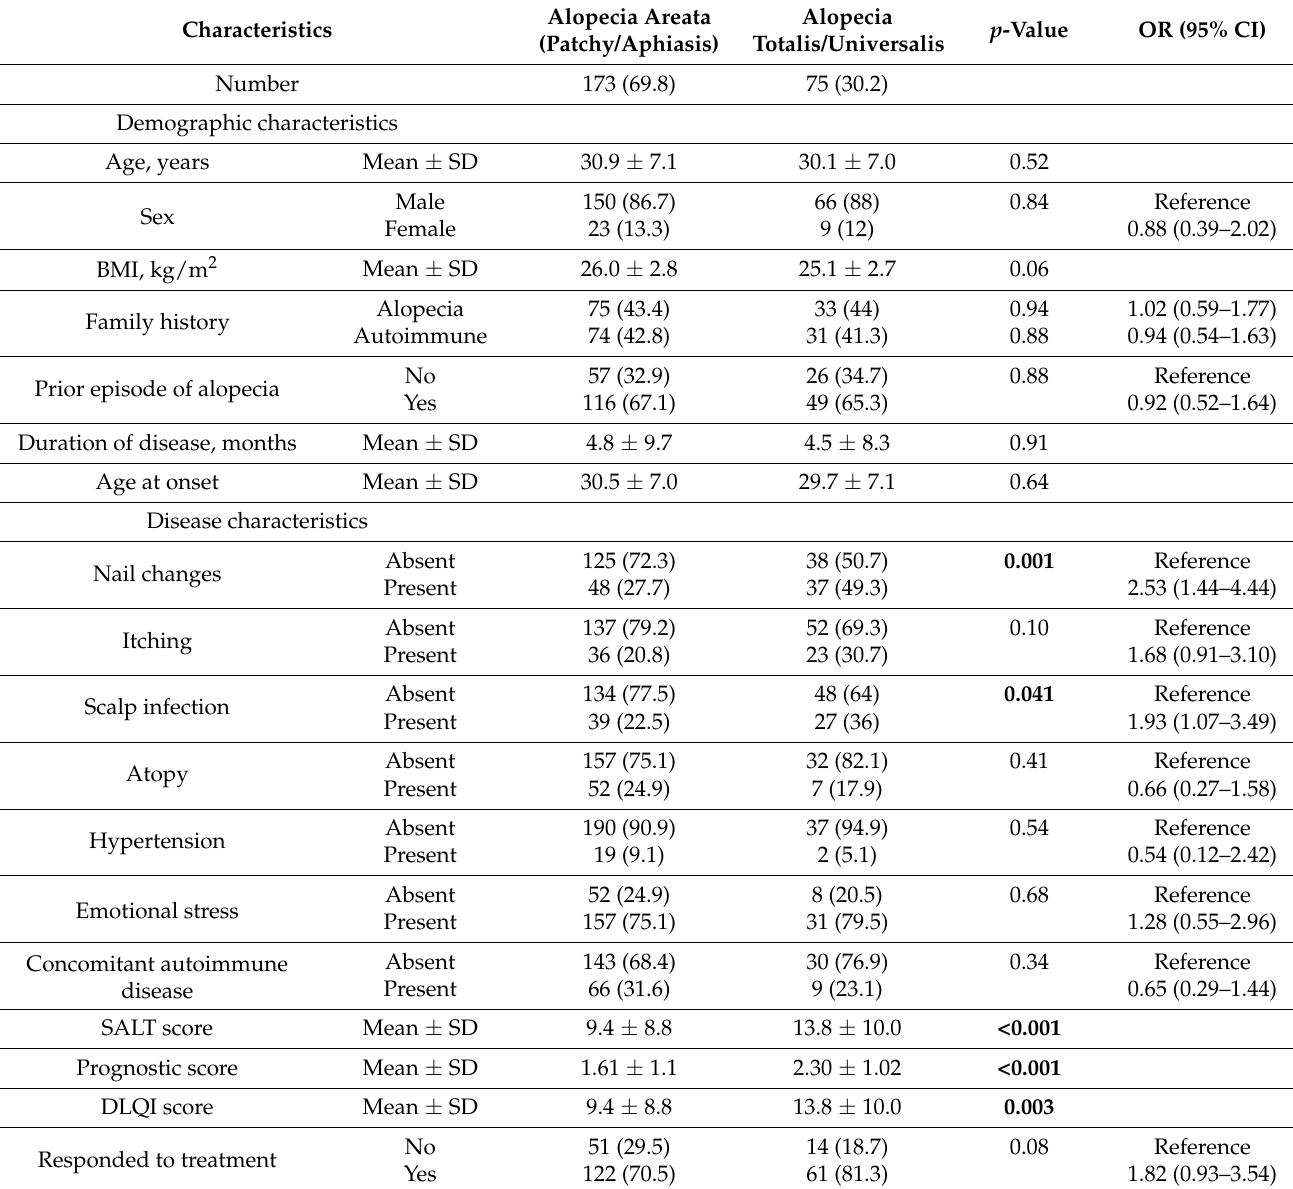
Table 2. Comparison between alopecia patients according to disease